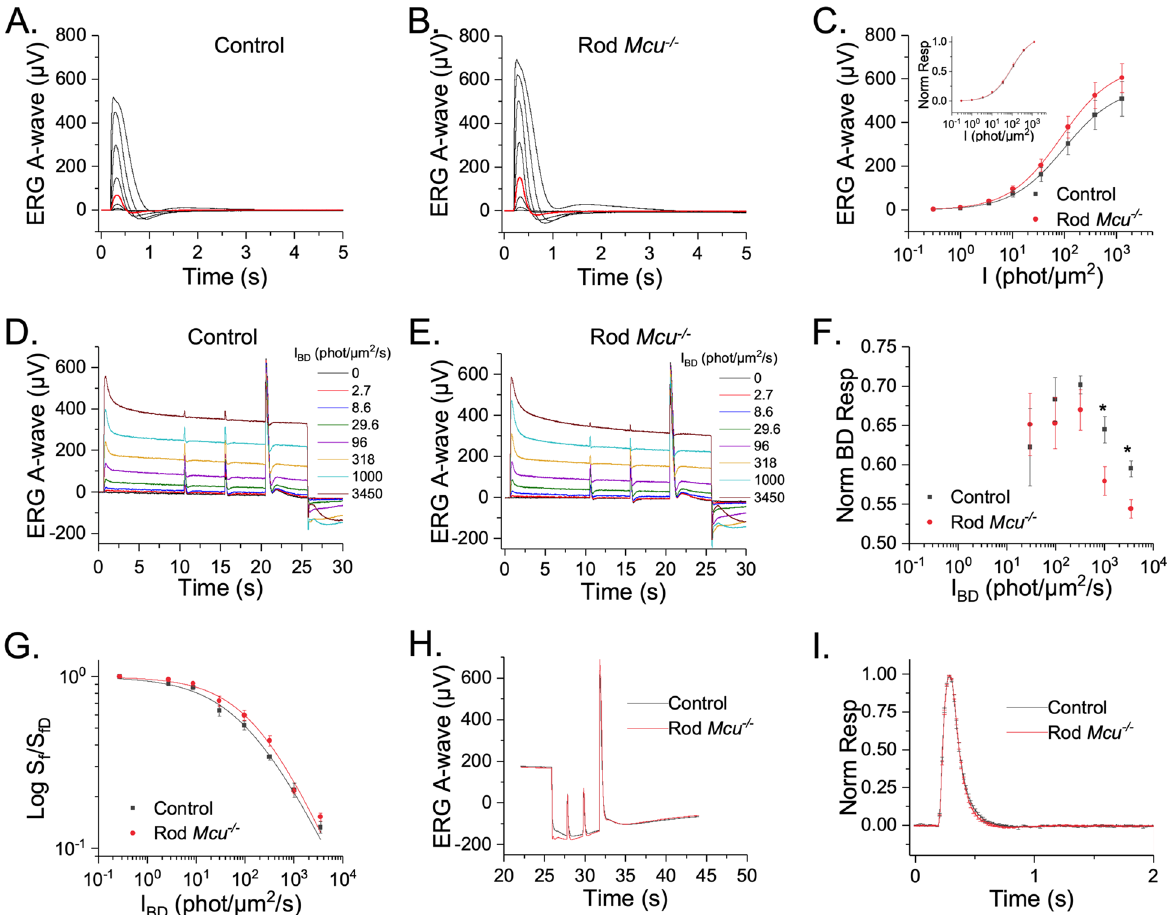
Figure 6. Mouse rods lacking Ca 2+ uptake through MCU exhibit normal photoresponse. ( A , B ) Flash response families of dark adapted iCre + (control; A ) and Mcu f/f iCre + (Rod Mcu -/- ; B ) mice from transretinal ERG recordings. Scotopic a-wave responses were recorded by a series of test flashes (1 ms in duration) with intensities (in photons/µm 2 ) 0.3, 1, 3.5, 10.2 (red traces), 35.4, 117, 385, 1270. ( C ) Averaged rod responses (Mean ± SEM) from control (black) and Rod Mcu -/- mice (red) plotted as a function of flash intensity show only a marginal ( p > 0.05) difference in the response amplitude between these groups (n = 10 for each). The solid lines represent curves fitted to the intensity response using the Naka–Rushton Function, R/R max = I/(I + I 1/2 ). (Inset) Normalized intensity response curves showing no difference in sensitivity between control (black) and Rod Mcu -/- (red) mice. ( D , E ) ERG responses to steps of incremental background illumination of control ( D ) and Rod Mcu - /- mice ( E ) with subsequent responses to dim and saturating light flashes (n = 8 for each). ( F ) The background light response at plateau, normalized to the peak of the initial background response, as a function of background light intensity. The plateau response for the two brightest backgrounds was significantly lower for the Rod Mcu -/- responses compared to these from controls (n = 8 for each). ( G ) Light-adapted sensitivity, normalized to the corresponding dark-adapted value, plotted as a function of background light intensity. Solid lines represent curves fitted to the response plots using the Weber Fechner function. (n = 8 for each). ( H ) Rod sensitivity during subsequent dark adaptation was estimated from ERG responses to dim flashes recorded at 2 s and 4 s after turning off a step of background light; averaged traces for control (black; n = 8) and Rod Mcu -/- (red; n = 12) retinas are shown. No notable differences in the kinetics of the dim flash response between control and Mcu -/- rods at both 2 s and 4 s time points for the two brightest background steps (1000 and 3450 photons/μm 2 /s) were evident. ( I ) A representative plot for the flash responses recorded at 4 s after turning off the highest background (3450 photons/μm 2 /s) shows identical kinetics between control (n = 8) and Rod Mcu -/- (n = 12) mitochondrial Ca 2+ uptake (MCU) is tolerated surprisingly well by photoreceptors. MCU-deficient photorecep- tors appear healthy, their TCA cycle activity is largely unaltered, and the photoresponse is preserved. In cones from global mcu -/- zebrafish, cytosolic Ca 2+ is cleared more slowly and mitochondrial Ca 2+ uptake is reduced in a significant population of mitochondria. However, some mitochondria still display robust increases in mito- GCaMP3 fluorescence in the absence of MCU. Ca 2+ uptake in these mitochondria appears to occur more slowly and with a lower magnitude than in WT mitochondria. Consistent with this result, we found that both WT and mcu -/- cones have a population of mitochondrial clusters which still appear to take up Ca 2+ even in the presence of the MCU inhibitor Ru360, and the characteristics of this population match those of the responding mito- chondria in mcu -/- cones. This is similar to what has been observed in non-synaptic brain mitochondria isolated